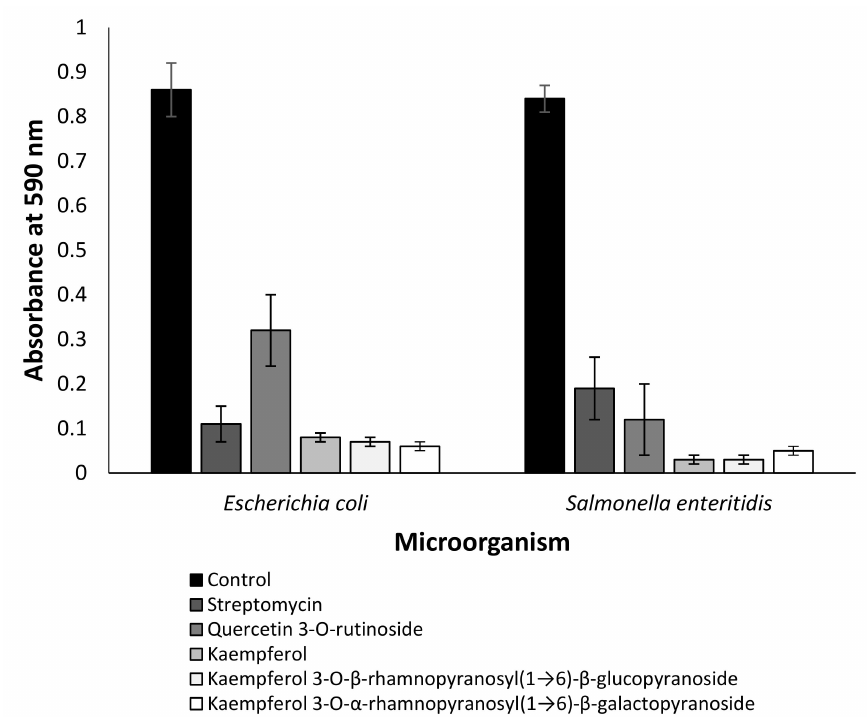
Figure 3. Effect of quercitin 3- O -rutinoside, kaempferol and kaempferol glycoside derivatives on biofilm formation. The results are presented as the mean ± SE of the absorbance at 590 nm. The identi- fied compounds and streptomycin were used at a concentration of 2 µ M. Data from three independent experiments are